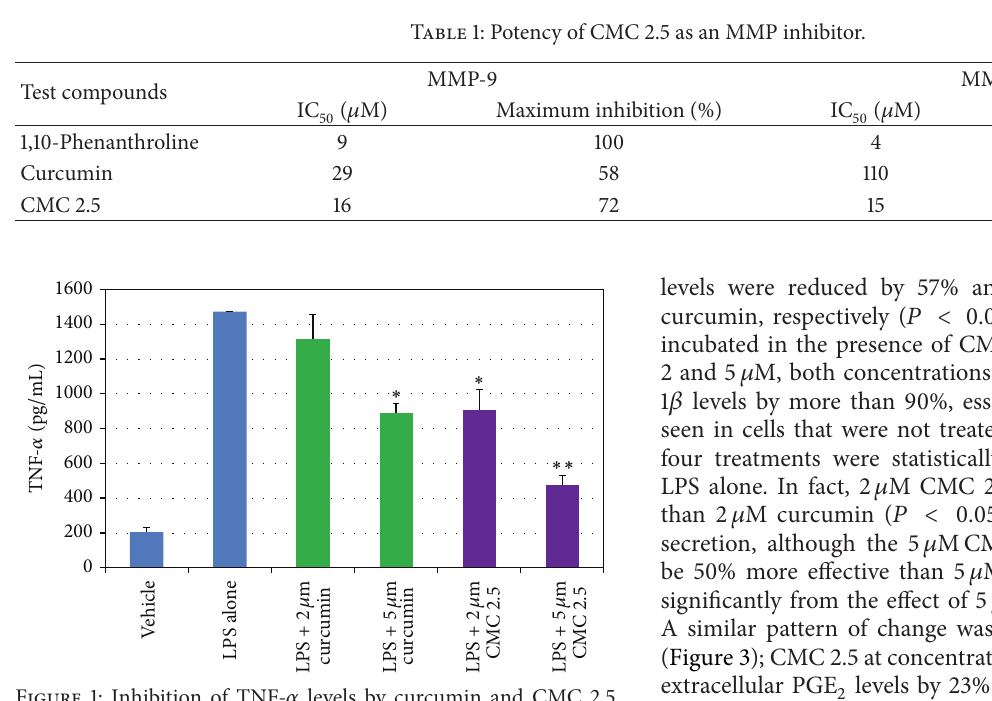
Figure 1: Inhibition of TNF- 𝛼 levels by curcumin and CMC 2.5 in PBMC cells. PBMC cells (5 × 10 5 cells/well) were cultured in serum-free media (37 ∘ C, 95% air, 5% CO 2 ) for 18 hours with LPS ( P. gingivalis , 50 ng/mL) or vehicle alone. Curcumin or CMC 2.5 was added at final concentrations of 2 or 5 𝜇 M. Conditioned medium was analysed for TNF- 𝛼 by ELISA. Each value represents the mean of 3 cultures ± the standard error of the mean (S.E.M.). ∗ 𝑃 < 0.05 represents the significance of all groups of curcumin and CMC 2.5 compared to LPS alone; ∗∗ 𝑃 < 0.05 represents the significance between LPS + 5 𝜇 M curcumin and LPS + 5 𝜇 M CMC